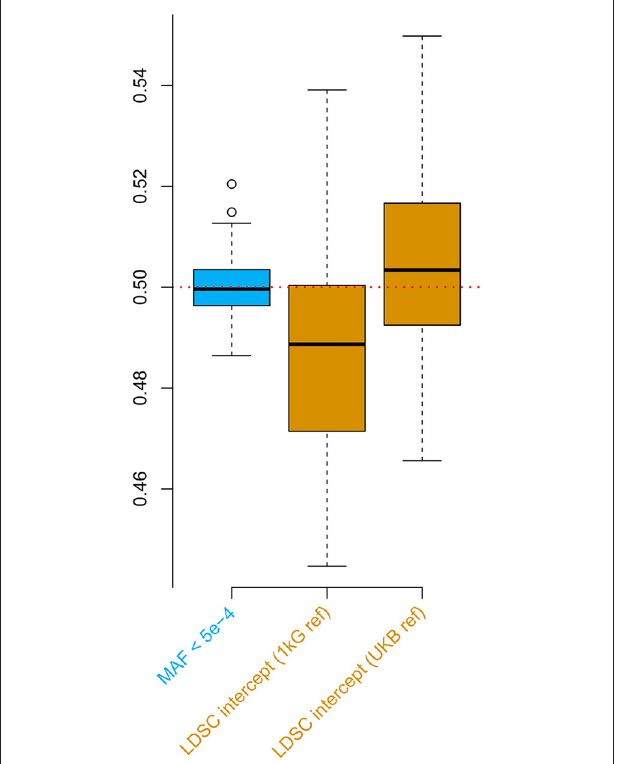
FIGURE 2 | Simulations comparing the low minor allele frequency (MAF) estimator and LD score regression (LDSC) intercept using the UK Biobank genotype data. The box plots show the results from 100 replicates, where in each replicate, two phenotypes with heritability of 0.5 were simulated for 336,000 genomic British individuals. The true phenotypic, genetic, and residual correlations were all set to 0.5. The low MAF estimates were based on 70,042 single nucleotide polymorphisms (SNPs) with MAF < 5 ref: LD scores calculated based on the 1000 Genomes reference panel; UKB ref: LD scores calculated based on the UK Biobank reference